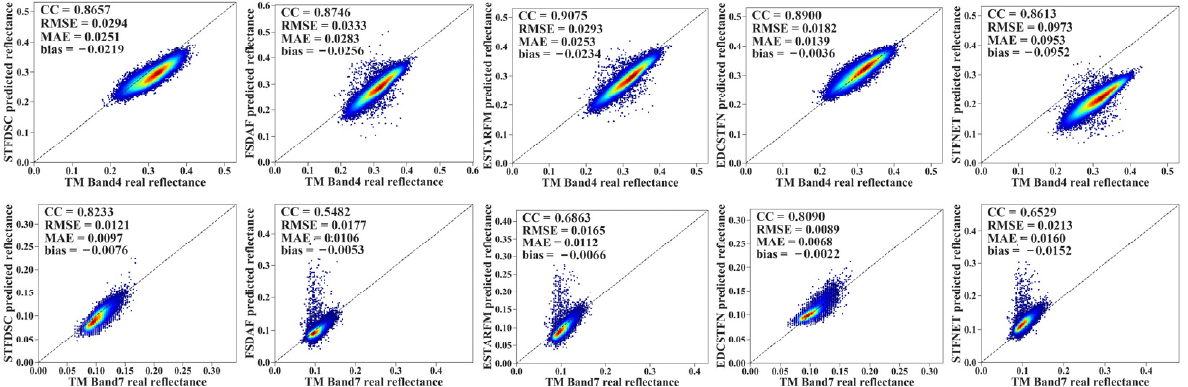
Figure 6. Density scatter plot of the observed reflectance and predicted reflectance at TM bands 4 and 7 in the ZWL.